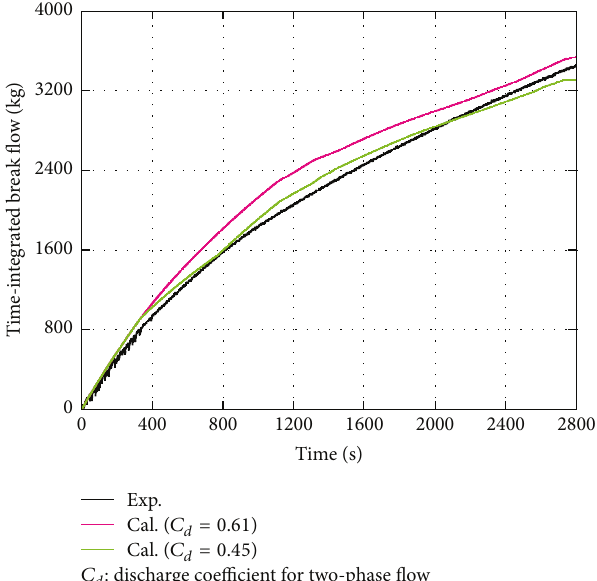
Figure 18: LSTF and RELAP5 results for time-integrated break flow in case of no release of dissolved gas.